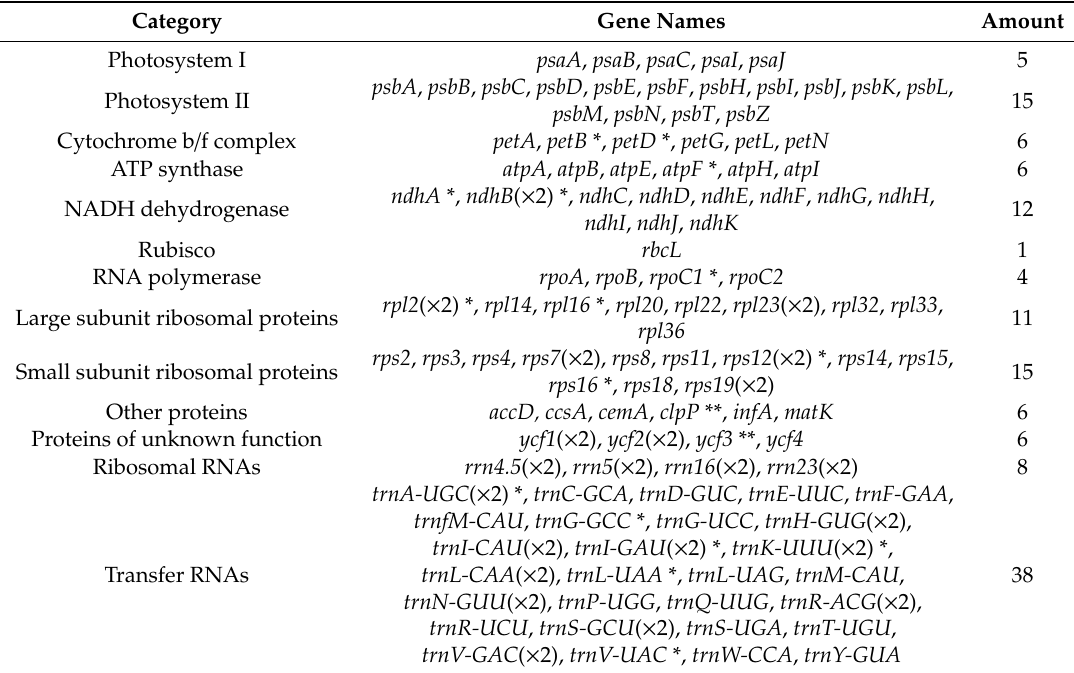
Table 2. Genes present in the chloroplast genomes of three Alpinia species. Category Gene